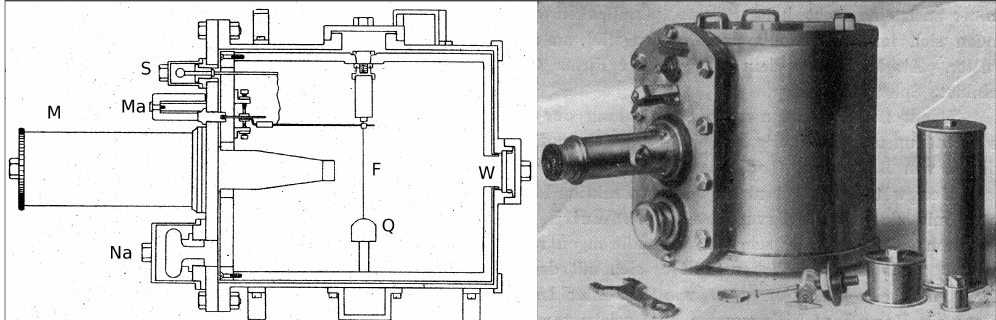
Figure 6. Further modified Wulf-type γ -ray electrometer after Kolh¨orster’s suggestions. (Ma) is the magnet-operated device to connect the electrode (S) to the filaments (F). Other letters are the same as in Fig. 5. The operating elements could be protected with metal covers during transport, seen on the photograph at right.